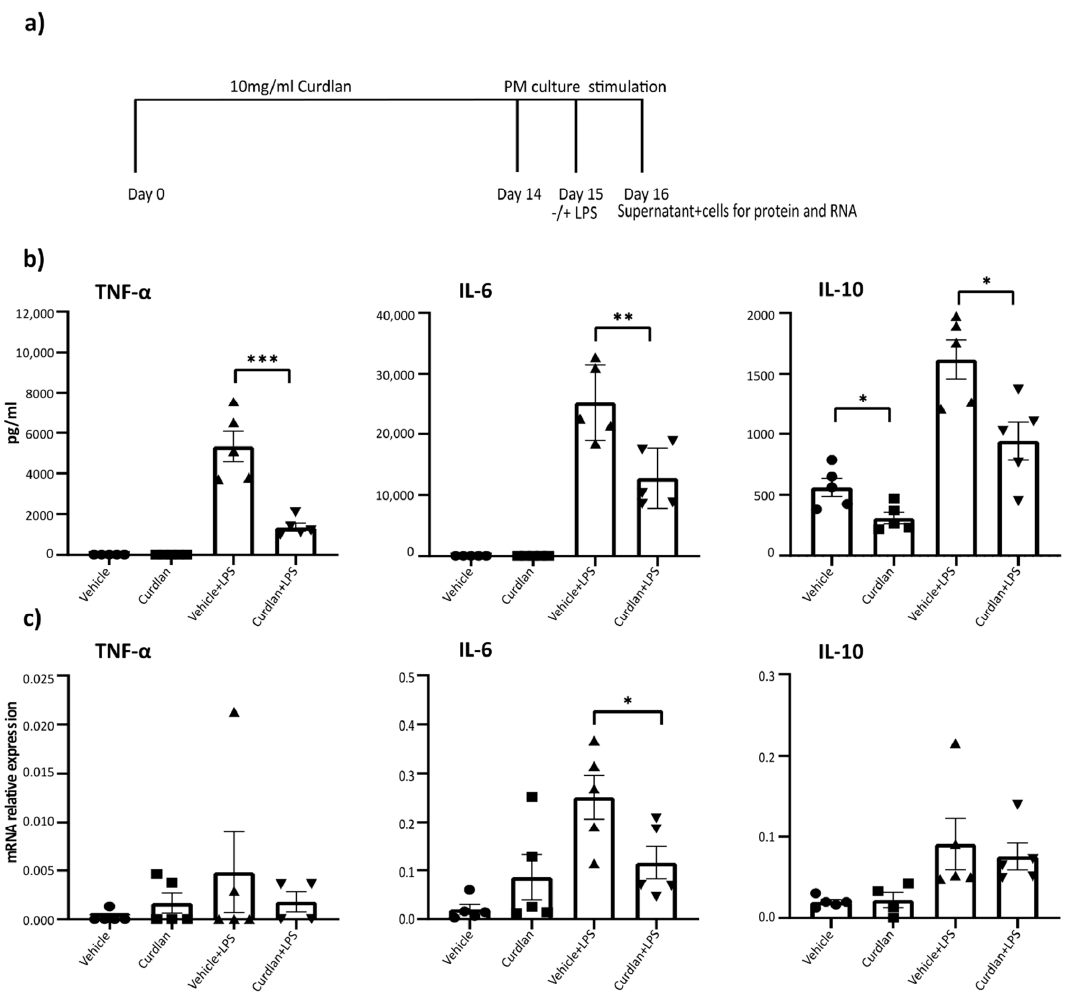
Figure 2. Curdlan intake results in reduced lipopolysachcharide (LPS) responses in peritoneal macrophages. ( a ) A schematic presentation of curdlan feeding in mice and peritoneal macrophage stimulation. ( b ) Cytokine response by peritoneal macrophages after LPS stimulation for 24 h. ( c ) mRNA gene expression levels of TNF- α , IL-6 and IL-10 after 24 h of LPS stimulation. The levels of mRNA were normalized for reference genes. Samples with no amplification and below detection levels were considered as 0. N = 3–5 for each condition. Individual values are expressed as mean and standard error of mean. Statistical differences were tested by independent t -test, where a p -value of <0.05 was considered to be significant. * p -value < 0.05; ** p -value < 0.01; *** p -value <